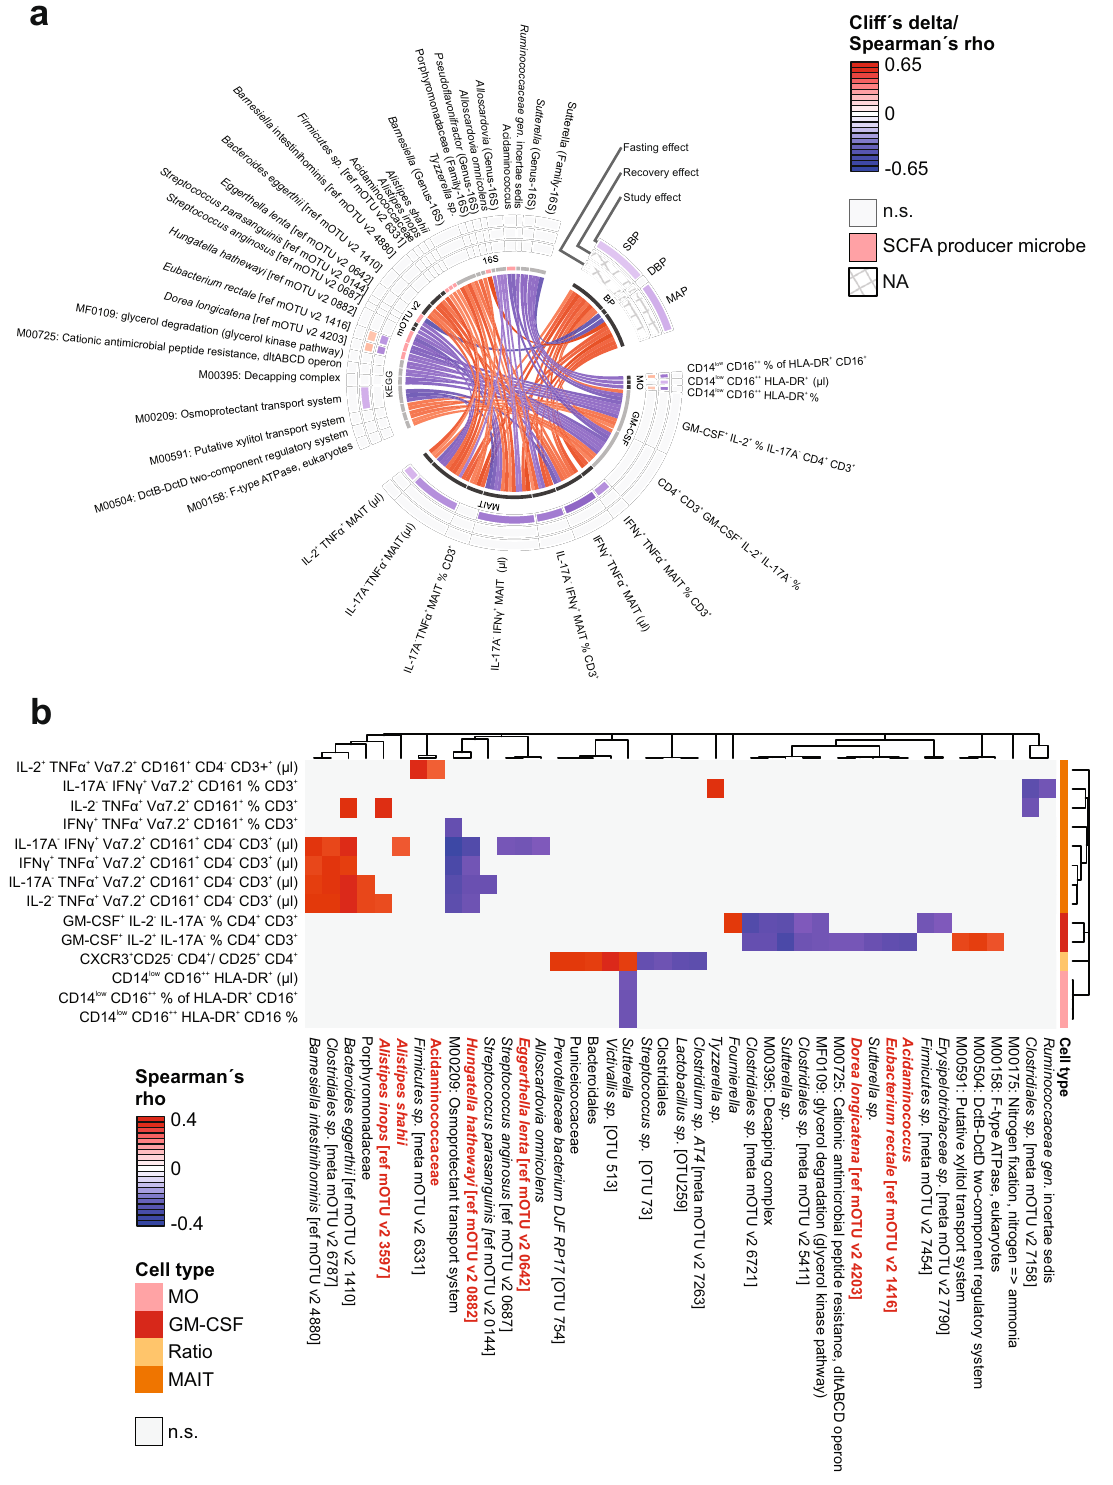
Fig. 5 Blood pressure-microbe-immune association. a Chord diagram visualizes the interrelation between BP (24 h ambulatory systolic, mean or diastolic BP) and fasting-impacted microbiome functional or taxonomic features, and immune cell subsets. Features are shown that form triplets of immune, microbial and phenotype variables where at least two of three correlations are signi fi cant (Spearman FDR < 0.05, post-hoc nested model test accounting for same-donor samples < 0.05) in the fasting arm of our cohort, and where in addition one or more features is signi fi cantly (drug-adjusted post-hoc FDR < 0.05) affected by the intervention. Color of the connectors indicates positive or negative association (Spearman ’ s rho), color of the cells within the tracks indicates changes upon fasting, refeeding and study effect (Cliff ’ s delta, white if not signi fi cant), respectively. b Hierarchical clustering of microbiome features-associated immune features. Color indicates Spearman ’ s